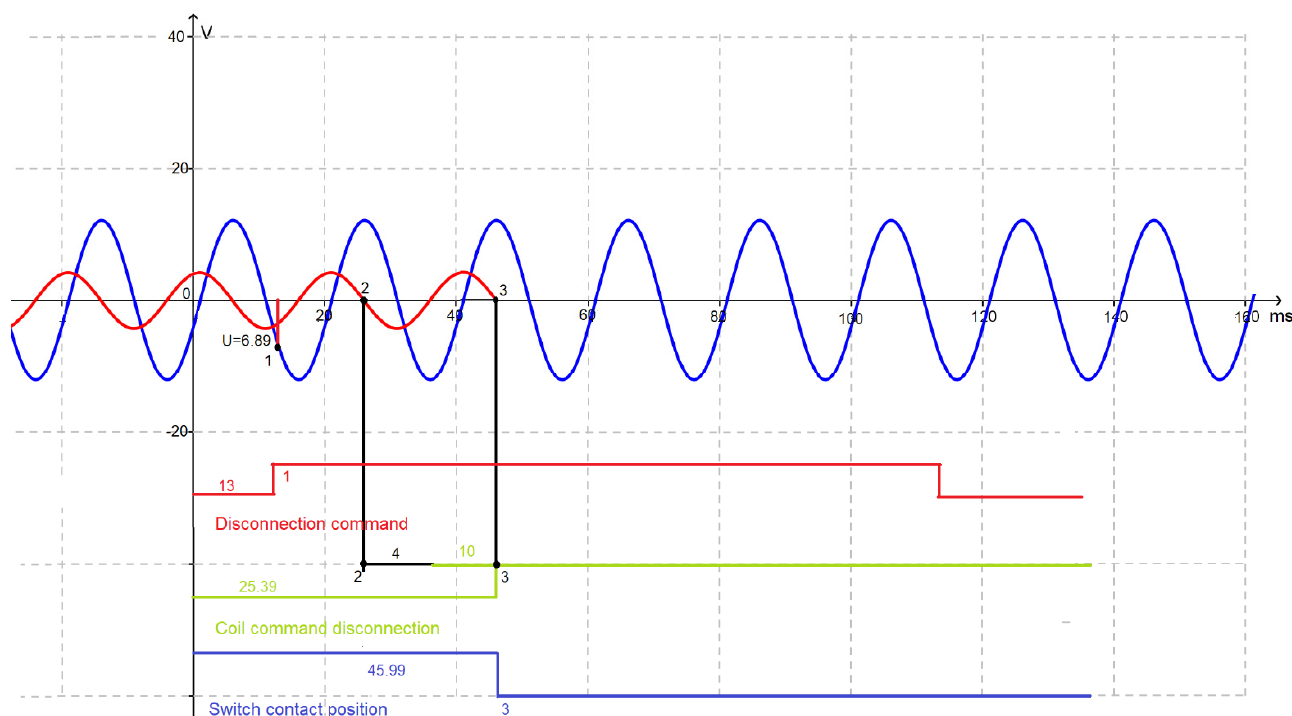
Figure 15. The simulation of monophasic power supply system on the disconnecting process of the circuit breaker on t 1 = t command = 13 ms.